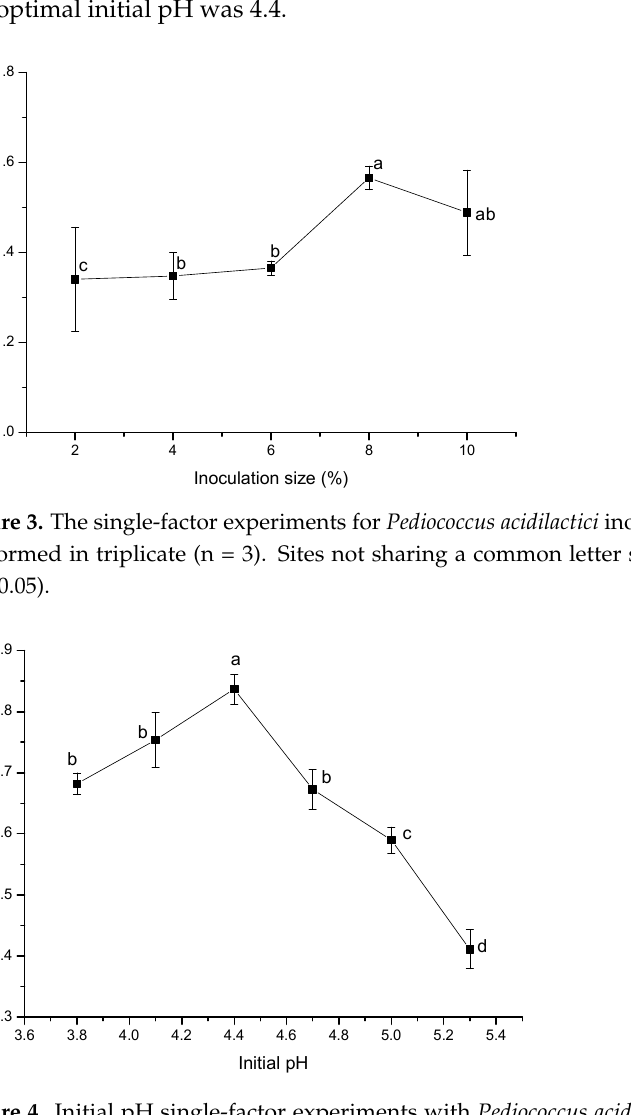
Table 7. Orthogonal test of fermentation conditions for Pediococcus acidilactici. Test Number